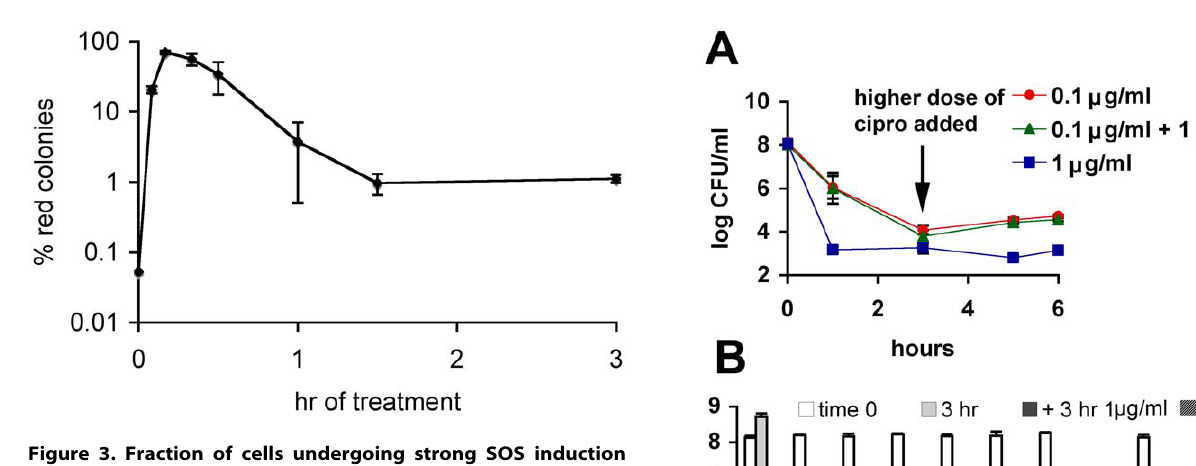
Figure 3. Fraction of cells undergoing strong SOS induction during ciprofloxacin challenge. Cells in exponential growth phase were exposed to ciprofloxacin. A heritable epigenetic switch based on the reciprocal repression of the phage l cI and cro genes fused with the promotorless galactose operon allows detection of clones derived from cells that have undergone SOS induction as red gal + colonies on MacConkey galactose plates. Data points are average of at least 3 independent experiments. Error bars represent standard